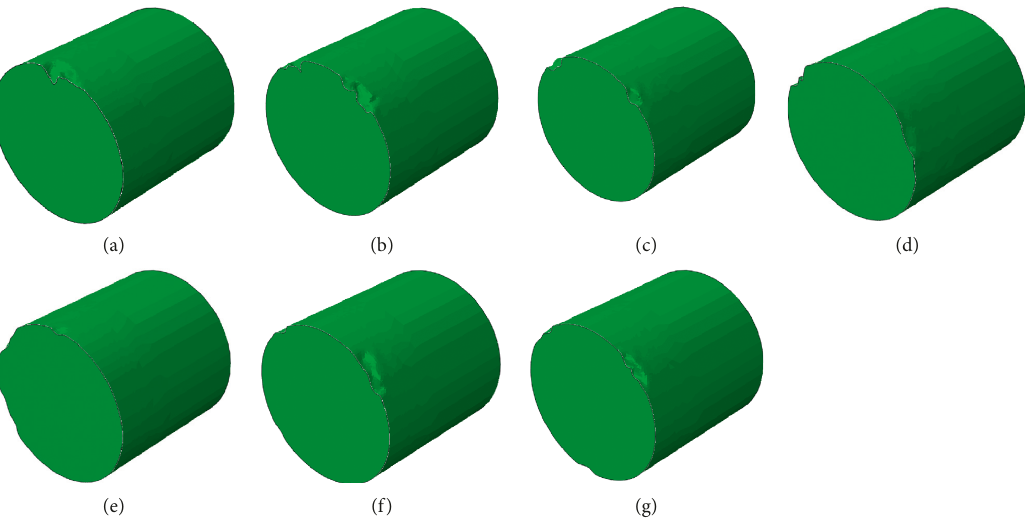
Figure 19: Steel wire model with the different planar multifatigue sources (view cut: z � 7mm): (a) Case A; (b) Case B; (c) Case C; (d) Case D; (e) Case E; (f) Case f; (g) Case